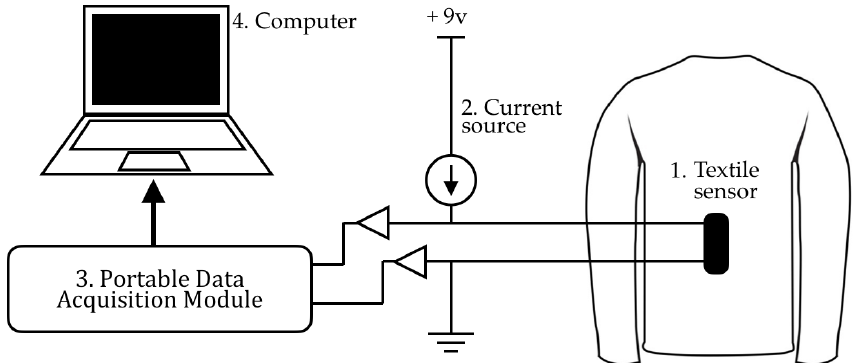
Figure 3. The block diagram of the electronic board and the system configuration as developed for use within TMS. The BWS, electronic board (includes: battery, current source, and potentiometer elements), portable data acquisition module, and computer are numbered 1 to 4, respectively. Due to the difference among sample sensors in their initial resistances, the potentiometer was regulated for each sample such that the BWSs’ signals start from around 1 V.